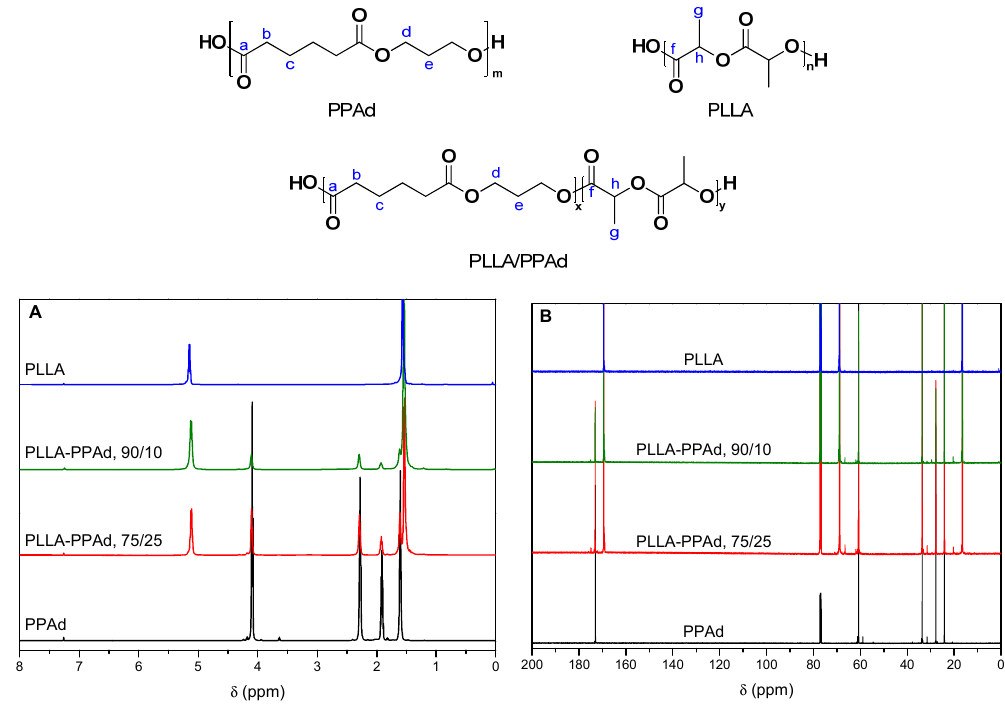
Figure 3. ( A ) 1 H-NMR and ( B ) 13 C-NMR spectra of PLLA, PLLA- b -PPAd copolymers and Figure 3. (A ) 1 H-NMR and ( B ) 13 C-NMR spectra of PLLA, PLLA- b -PPAd copolymers and PPAd. 1 H-NMR spectra of copolymers were similar for all the copolymers synthesized, and exhibited